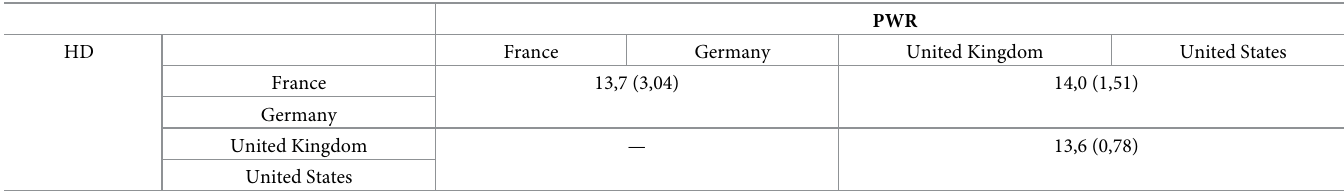
Table 2. Time lag between highest degree and prize-winning research.